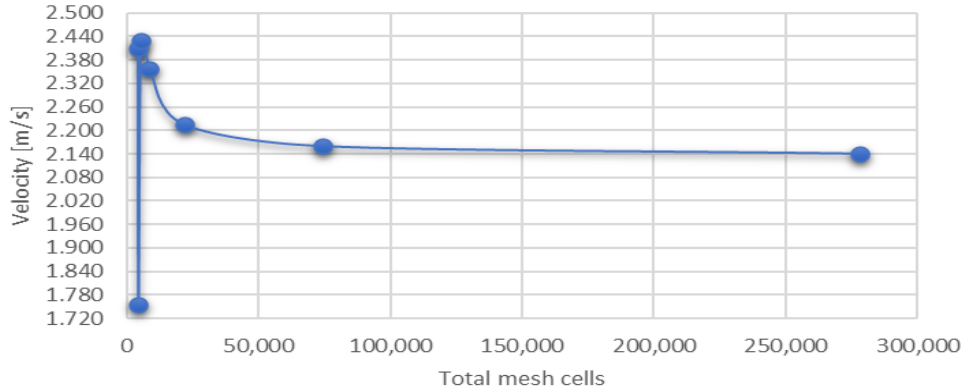
Figure 7. Maximum velocity of each refinement versus total number of mesh cells for the geometry with lateral air inlet and outlet.